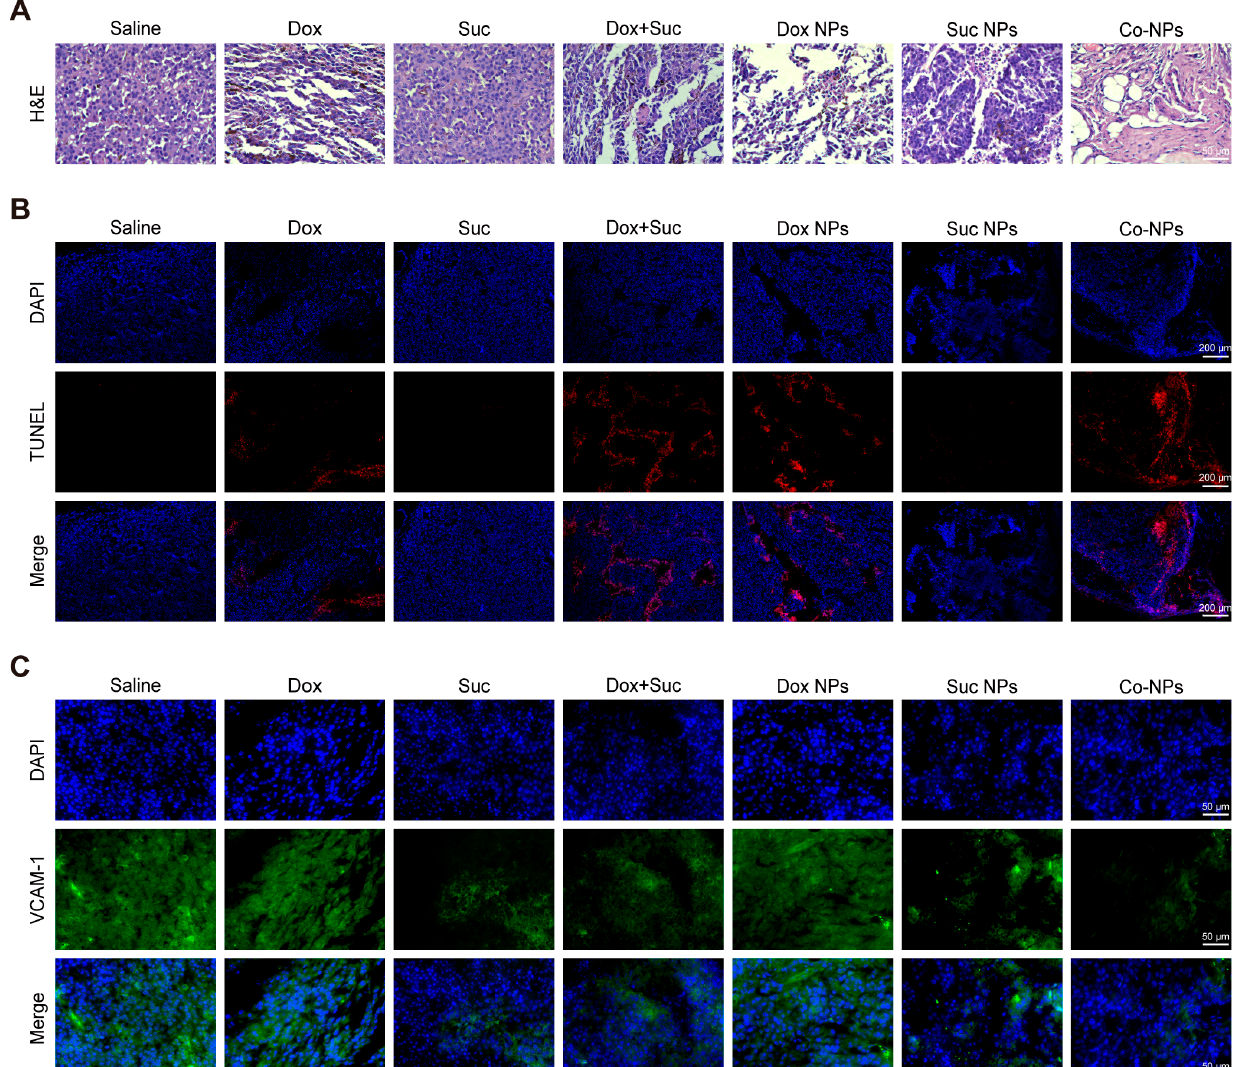
Figure 6. In vivo anti-primary tumor efficacy. ( A ) H&E staining of tumor tissues after different treatments. Scale bar = 50 μ m. ( B ) TUNEL staining of tumor tissues after different treatments. Scale bars = 200 μ m. ( C ) Immunofluorescence staining of VCAM-1 expression on tumor tissues after different treatments. Scale bars = 50 μ m.